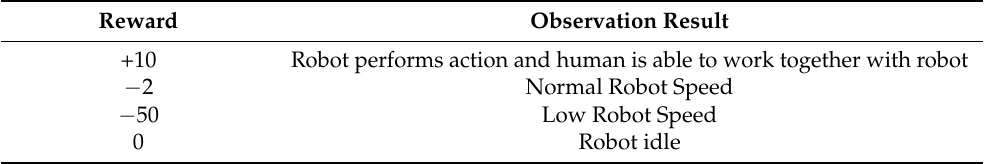
Table 5. Reward in the proposed